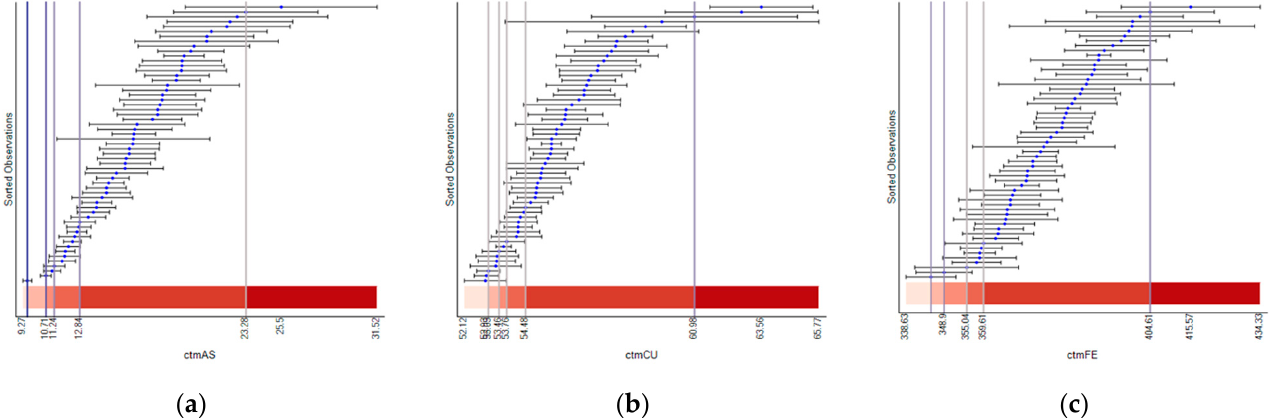
Figure 5. Illustrative heavy metals classification results for assay error and their corresponding resampling error: ( a ) As, ( b ) Cu, and ( c ) Fe.